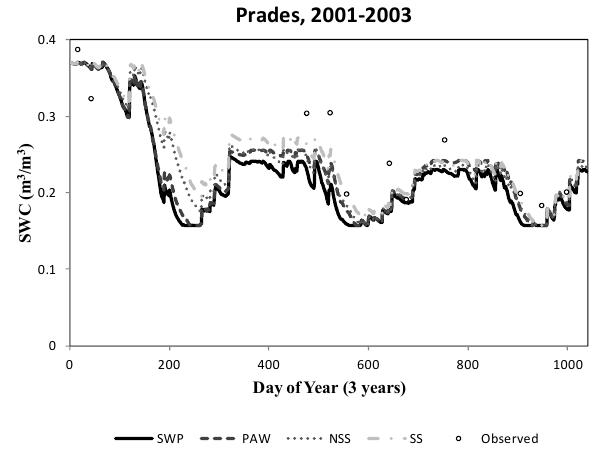
Fig. 10. Comparison of modelled and observed soil water content (SWC) from 2001 to 2003 for a holm oak stand at Prades using 4 methods that relate soil water to g sto (see methods section for